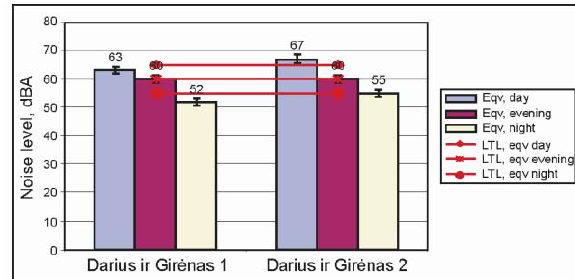
Fig. 26. Dynamics of equivalent noise levels in Darius and Girėnas street within twenty four